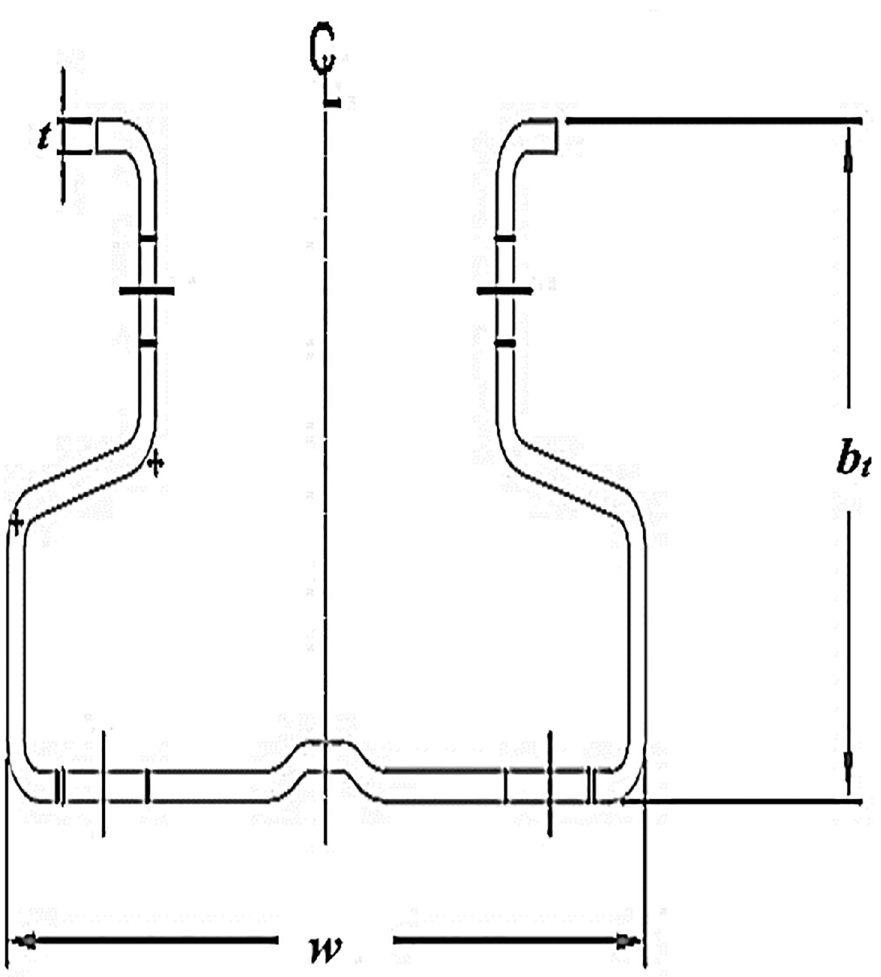
Fig 1. Cross-section of the